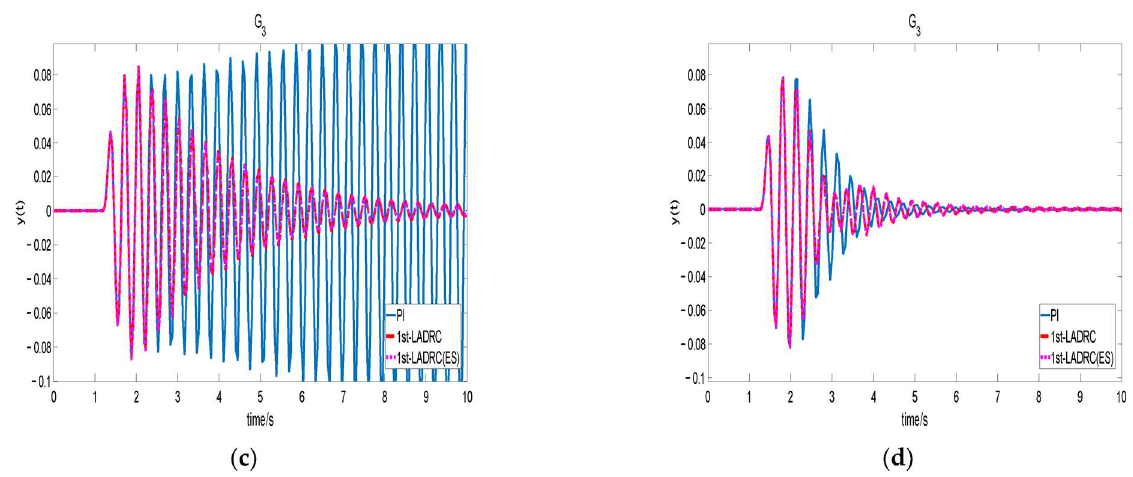
Figure 12. The response of G 3 under PI and LADRCs with different time delays. Step response curve when τ decreases by 30% ( a ) and increases by 30% ( b ). Disturbance response curve when τ decreases by 30% ( c ) and increases by 30% ( d